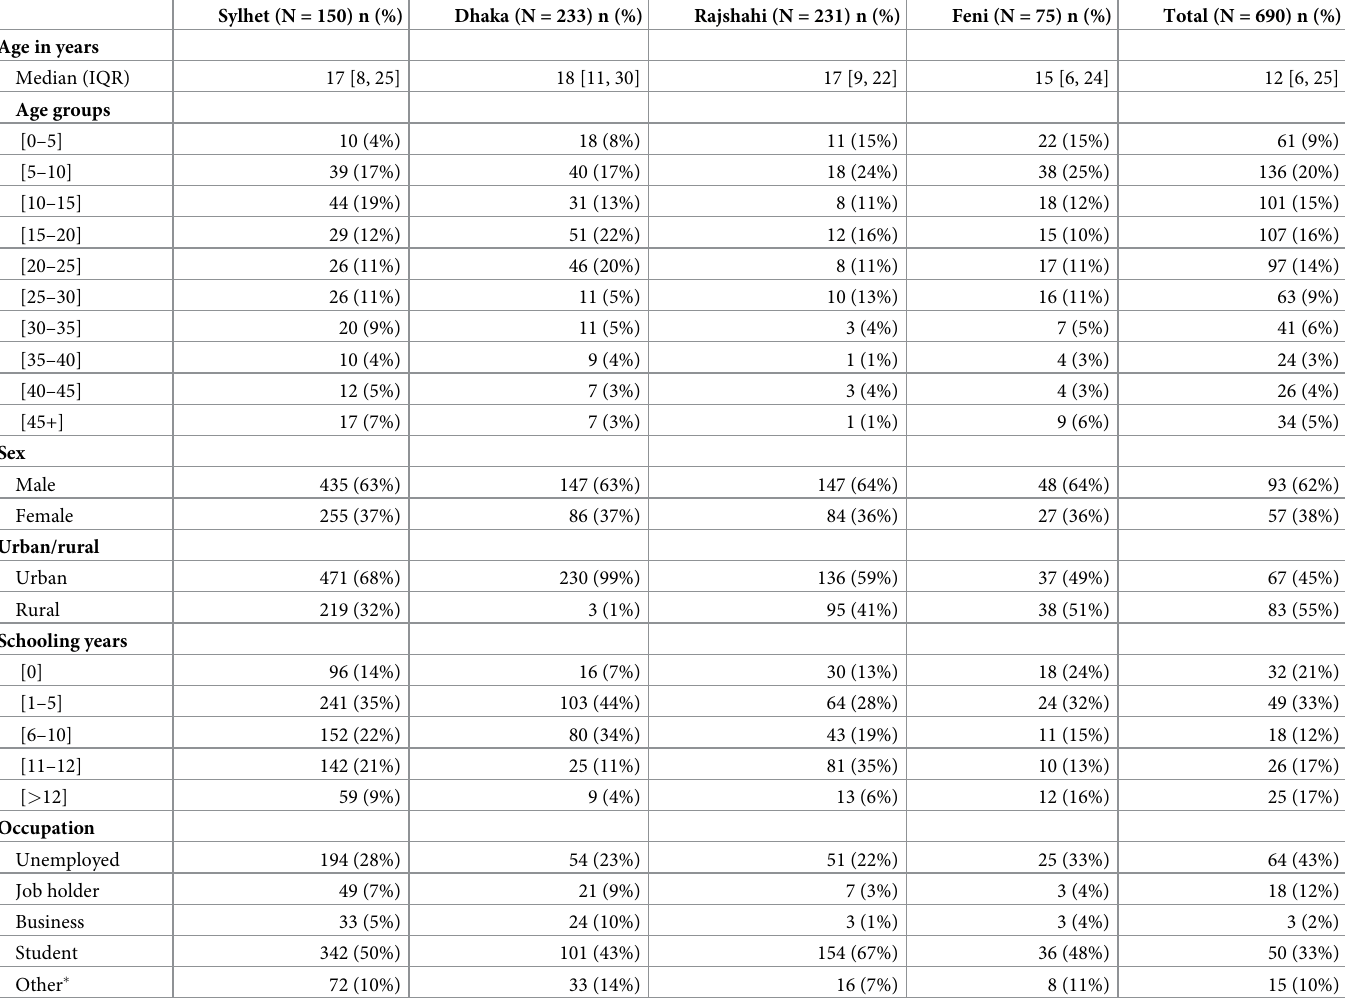
Table 1. Demographic characteristics of enrolled acute febrile illness (AFI) patients in Bangladesh, May 2019-March 2020. Sylhet (N = 150) n